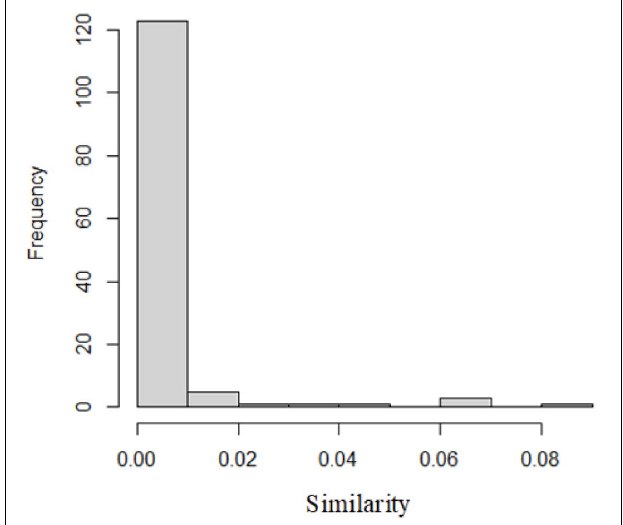
FIGURE 1 | The distribution of